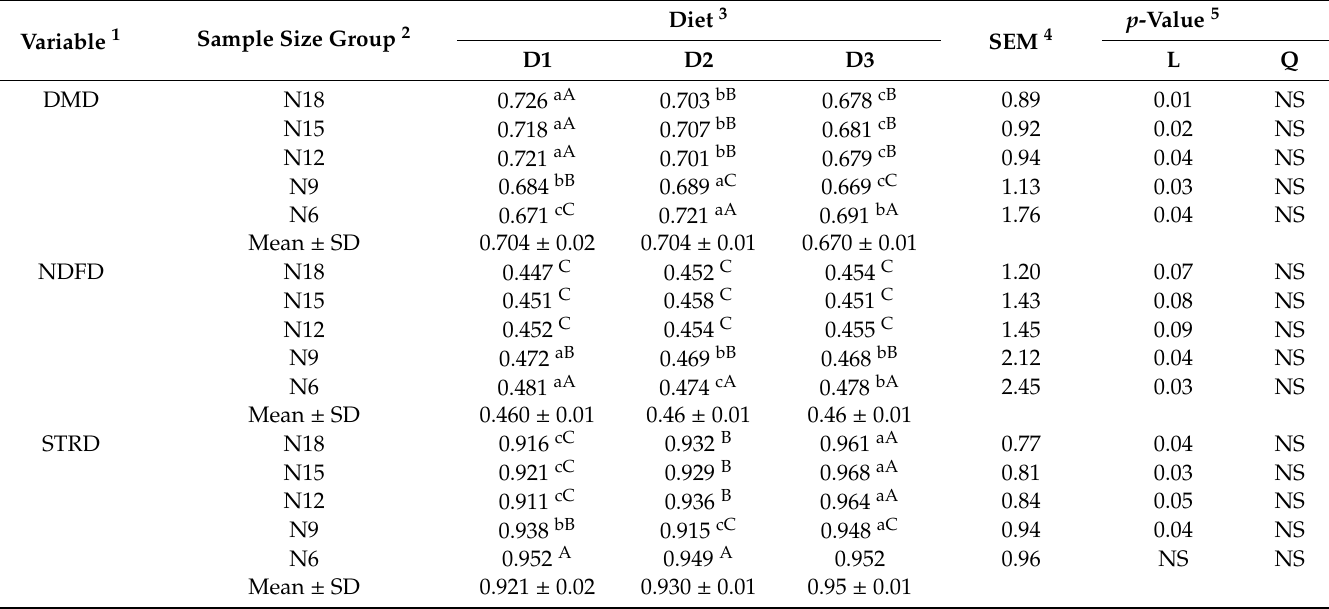
Table 4. E ff ect of diet on nutrient digestibility of dairy cows fed corn-based diets in di ff erent sample size groups ( n = 162). Variable